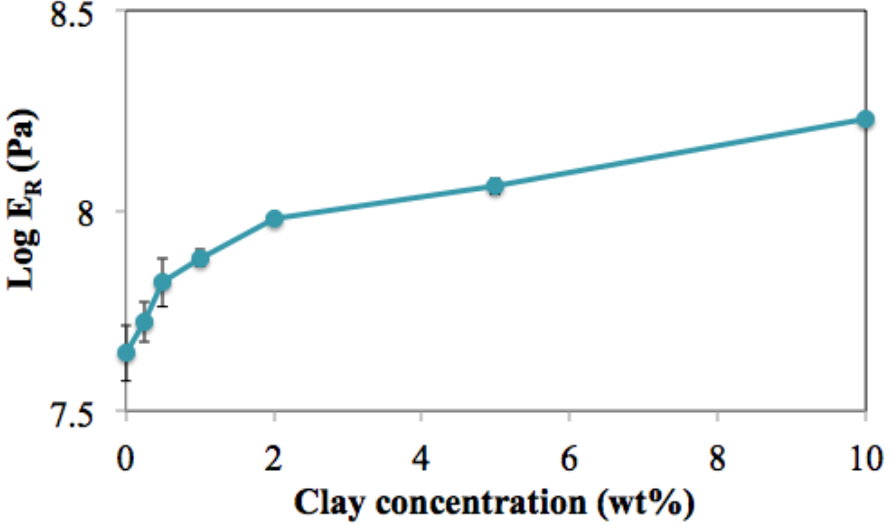
Figure 7. Effect of clay wt.% on the rubbery plateau modulus at 40 °C. The rubbery plateau modulus, E R increases with increasing clay wt.% due to increasing concentration of entanglement and physical crosslinks which increases chain rigidity and stiffness.